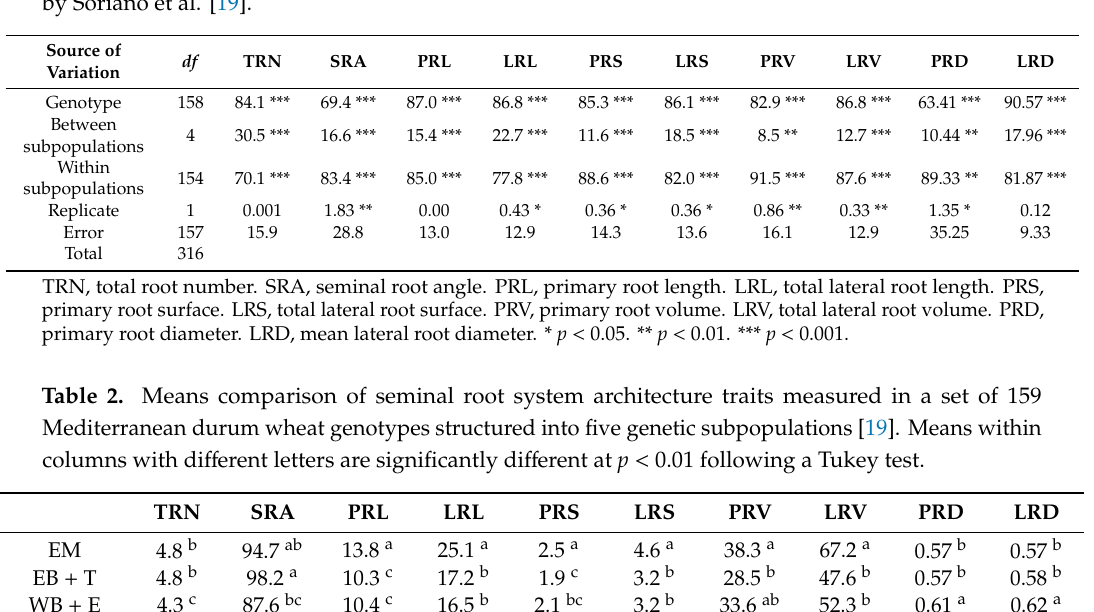
Table S2. The partitioning of the sum of squares of the cultivar e ff ect into di ff erences between and within SPs revealed that the variability induced by the genotype was mainly explained by di ff erences within SPs on a range from 70.1% for TRN to 91.5 for PRV (Table 1). Di ff erences between SPs were statistically significant for all traits, accounting for 8.5% (PRV) to 30.5% (TRN) of the sum of squares of the genotype e ff ect (Table 1). Western Mediterranean landraces showed the highest number of seminal roots and the narrowest root angle, whereas the eastern Balkans and Turkey SP showed the widest angle (Table 2). The highest values for root size–related traits (length, surface and volume) in both primary and lateral roots were recorded in the eastern Mediterranean landraces. The western Balkans and Egypt subpopulation showed the largest root diameter (Table 2). The comparison of mean values of eastern Balkans and Turkish landraces revealed that the Turkish ones had high values for all traits except TRN, LRL, and root diameter (Supplementary Materials Table S3). The modern cultivars showed intermediate values for all RSA traits (Table 2). Table 1. Percentage of the sum of squares of the ANOVA model for the seminal root system architecture traits in a set of 159 Mediterranean durum wheat genotypes structured into five genetic subpopulations by Soriano et al. [19].